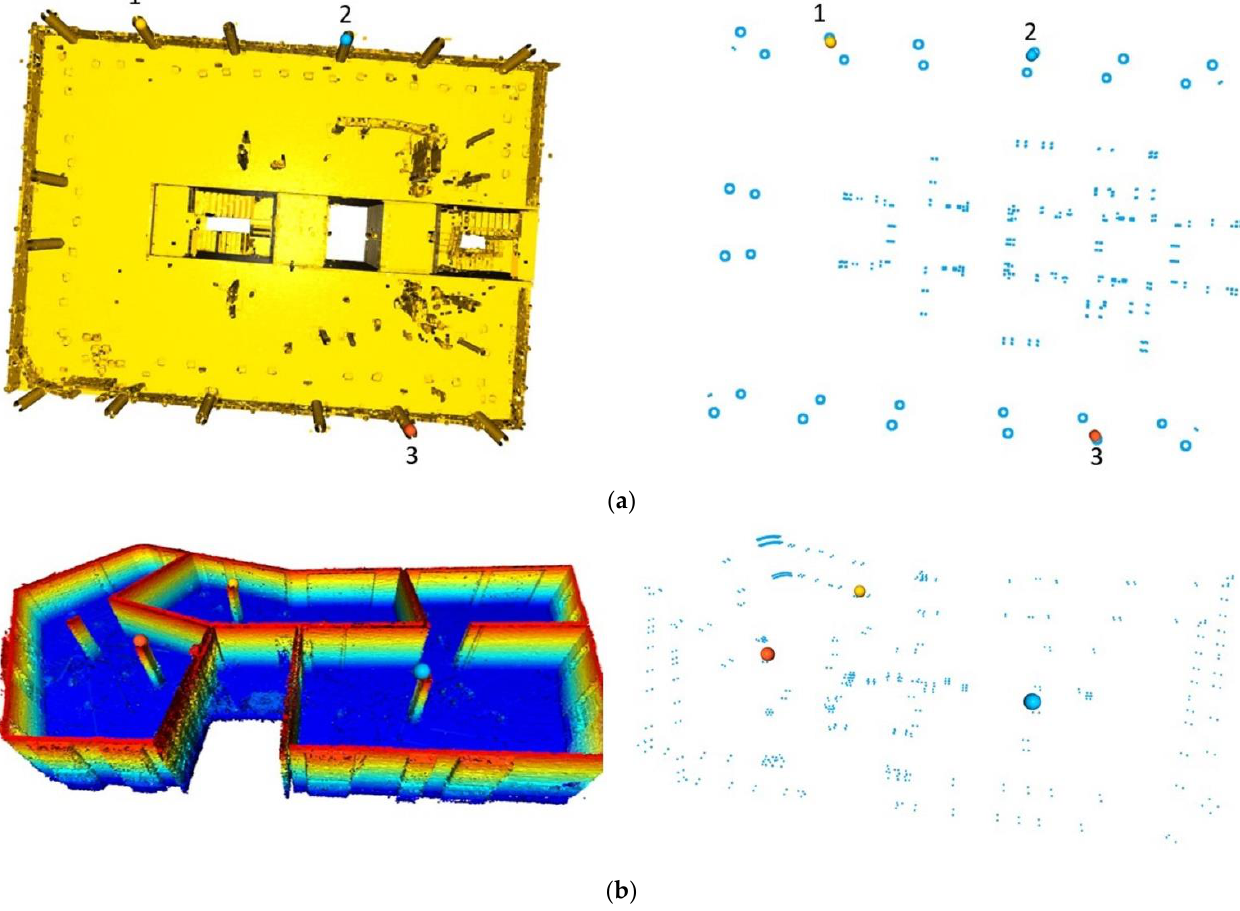
Figure 5. The three selected reference points are shown in yellow (1st), magenta (2nd), and orange (3rd): ( a ) office building, and ( b ) residential building.